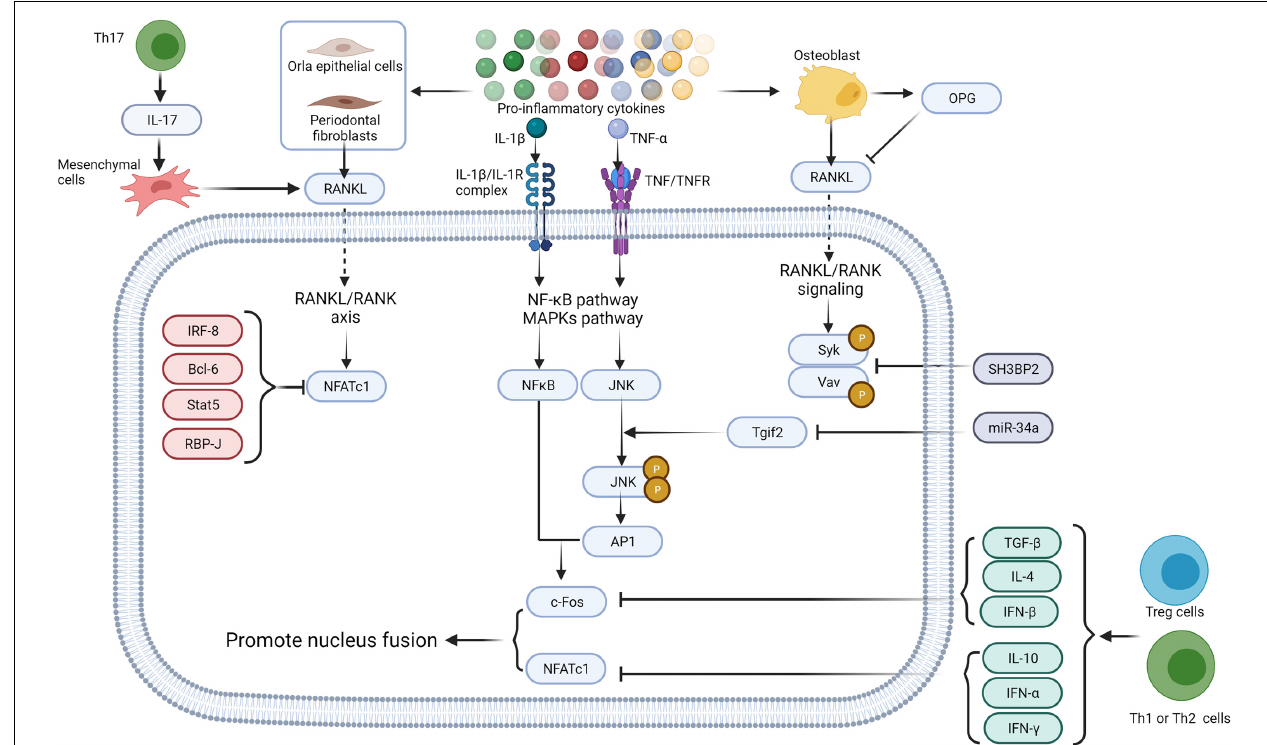
FIGURE 2 | Proinflammatory cytokines regulate osteoclastogenesis via direct interaction with their receptors. Proinflammatory cytokines such as IL-1 β , IL-6, IL-17, and TNF- α secreted by different immune cells induce RANKL production in endothelial cells (Batool et al., 2020), fibroblasts (Nagasawa et al., 2007; Hienz et al., 2015), and osteoblast lineage cells (Algate et al., 2016). OPG, secreted by osteoblast, works as a decoy receptor of RANKL to negatively regulate osteoclastogenesis (Lam et al., 2000). Intracellular IRF-8, Bcl6, Stat5, and RBP-J also negatively regulate osteoclastogenesis by inhibiting the expression of NFTAc1 (Ru and Wang, 2020). SH3BP2 (Ueki et al., 2007; Levaot et al., 2011) and miR-34a (Krzeszinski et al., 2014) negatively regulates Syk, Vav, and JNK protein phosphorylation. TGF- β , IFN- α , IFN- β , IFN- γ , IL-4, and IL-10 secreted by immune cells inhibit c-Fos thereby restrain osteoclastogenesis (Gao et al., 2007; Fujii et al., 2012; Xiong et al., 2016; Amarasekara et al., 2018), whereas IL-17 expressed by Th17 cells up-regulates RANKL expression in mesenchymal cells (Sato et al., 2006). Figure was created using